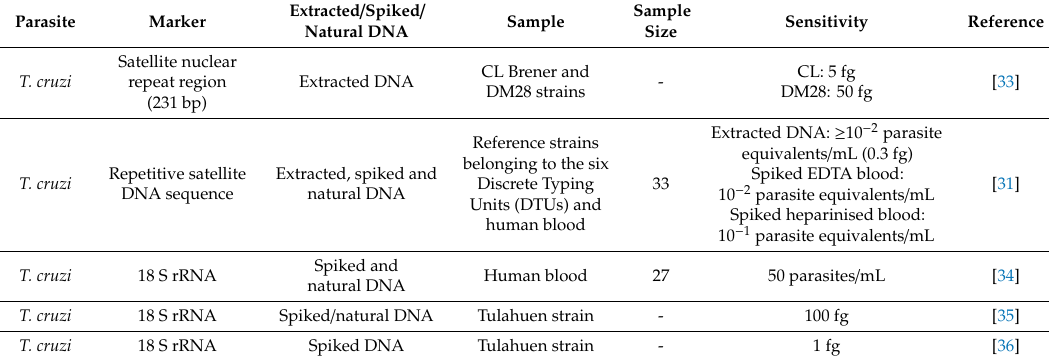
Table 1. Publications found in the US National Library of Medicine National Institutes of Health (NCBI-PubMed) reporting the standardisation of the loop-mediated isothermal amplification (LAMP) technique as a useful tool for diagnosing Chagas’ disease (American trypanosomiasis) in the definitive host.